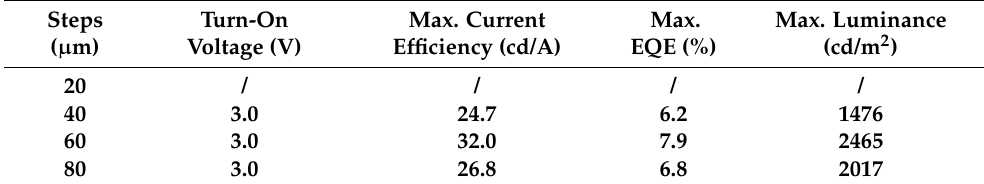
Figure 4. ( a ) Schematic of PeLED device structure; ( b ) energy band alignment of each layer in PeLED; ( c ) EL (at 5 V bias) and PL spectrum of perovskite nanocrystal fabricated via inkjet printing. ( d ) current density–luminance–voltage curve; ( e ) EQE–current density curve with different printed steps (40, 60, 80 μ m); ( f ) histogram of maximum EQE for 16 inkjet-printed PeLED devices. Table 3. Performance of PeLED with different printing steps.